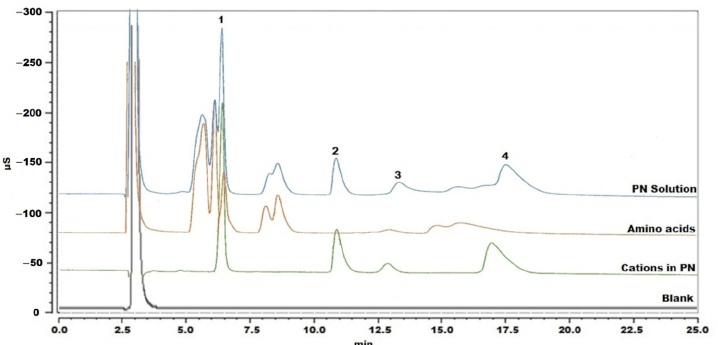
Figure 1 . Chromatogram of blank, standard solution of cations in the PN solution, mixture of amino acids and PN solution without pretreatment. Peak 1: sodium, peak 2: potassium, peak 3: magnesium and peak 4: calcium.